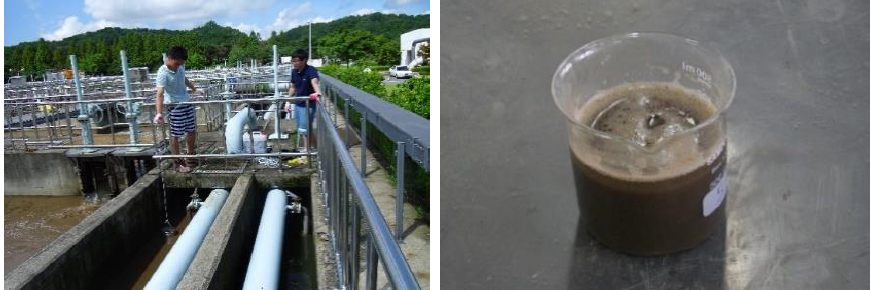
Figure 1. Solution of sampled microscopic organism.